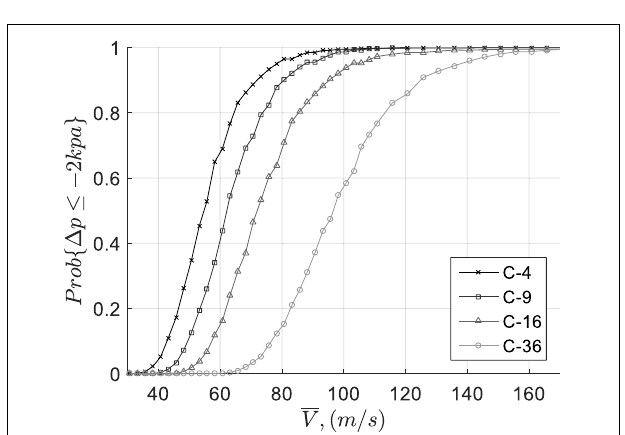
elevation angle, Δβ , such that C p ( θ , β ) = C p ( θ ) + ( dC p / d β ) Δβ . The gradient dC p / d β is found to vary with respect to